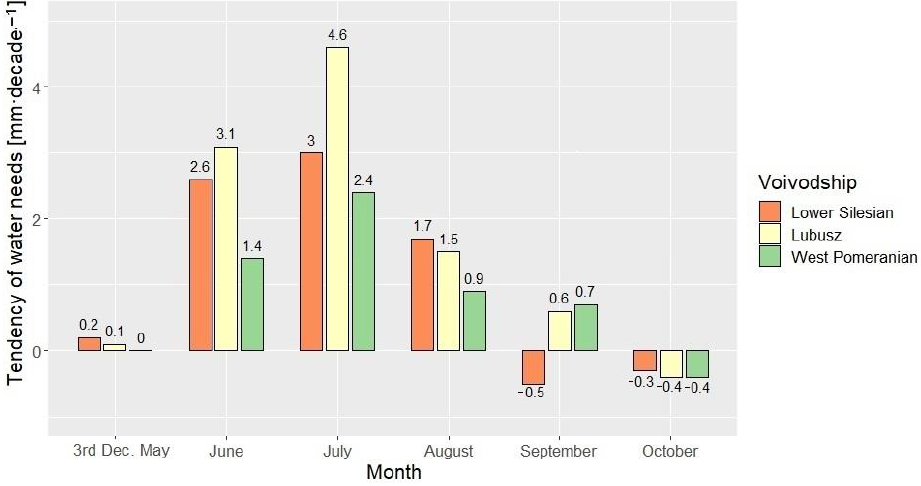
Figure 10. The trend of water needs of willow in each month for the analyzed voivodships.